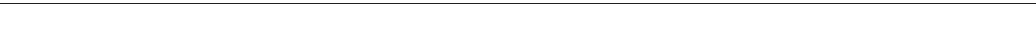
Fig. 6 PR-DUBs oligomerisation enables ef fi cient nucleosome recruitment. a Electrophoretic mobility shift assays comparing the ability of wild-type Calypso no tail – ASX and Calypso – ASX complexes to bind nucleosomes at varying protein concentrations (0.5, 1, 2, 4, 8 μ M). Recombinant nucleosomes reconstituted with a 220 bp Widom 601 DNA sequence labelled at the 5 ′ with an IRDye ® 700 were used to visualise nucleosomes. b Electrophoretic mobility shift assays testing the binding of wild type and L340A Calypso – ASX proteins to nucleosomes at increased protein concentrations (as for panel a ). Bands corresponding to the shifted nucleosome particle (indicated as shifted NCP) were quanti fi ed. Quantitated triplicates corresponding to three independent experiments are shown on the right, with a line passing through the mean. c Electrophoretic mobility shift assays comparing the ability of wild type and L635A BAP1 – ASXL1 complexes to bind nucleosomes at different protein concentrations (0.1, 0.2, 0.5, 1, and 2 μ M). Recombinant nucleosomes were reconstituted as outlined in a . Experiments were quanti fi ed as described in b . d Schematic representation of the mechanisms that underpin PR-DUB recruitment and activity on nucleosomes. In the absence of the C-terminal positively charged tails (left), the oligomeric PR-DUB complex cannot be recruited to nucleosomes, resulting in a total loss of activity and maintenance of the H2AK119Ub mark. The 1:1 PR-DUB complex (middle), despite the presence of the C-terminal tail, has reduced af fi nity for nucleosomes and hence limited ability to deubiquitinate H2AK119Ub. Only a PR-DUB complex that bears two C-terminal tails and that has full ability to form a bidentate complex (right) can be ef fi ciently recruited to nucleosomes, thereby resulting in increased activity. e Scale model for bidentate recruitment of the Calypso – ASX complex to H2AK119Ub nucleosomes. The Calypso dimer and ubiquitin are shown in surface representation, while the ASX Deubad domains are shown as cartoon; the surface of the nucleosome particle is represented as electrostatic potential. The C-terminal positively charged tails of the two Calypso molecules are shown in blue. Black arrows indicate the distances between the two Calypso active sites as well as between the two mono-ubiquitinated Histone 2A Lys119 residues of the nucleosome